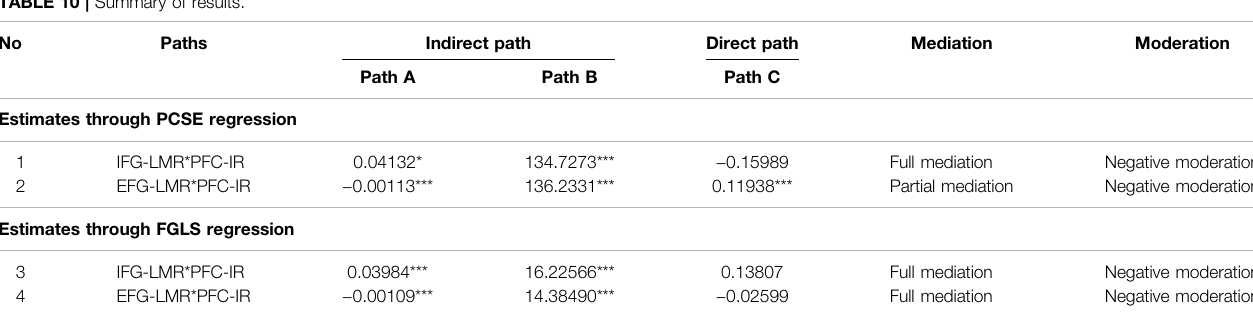
TABLE 10 | Summary of results.